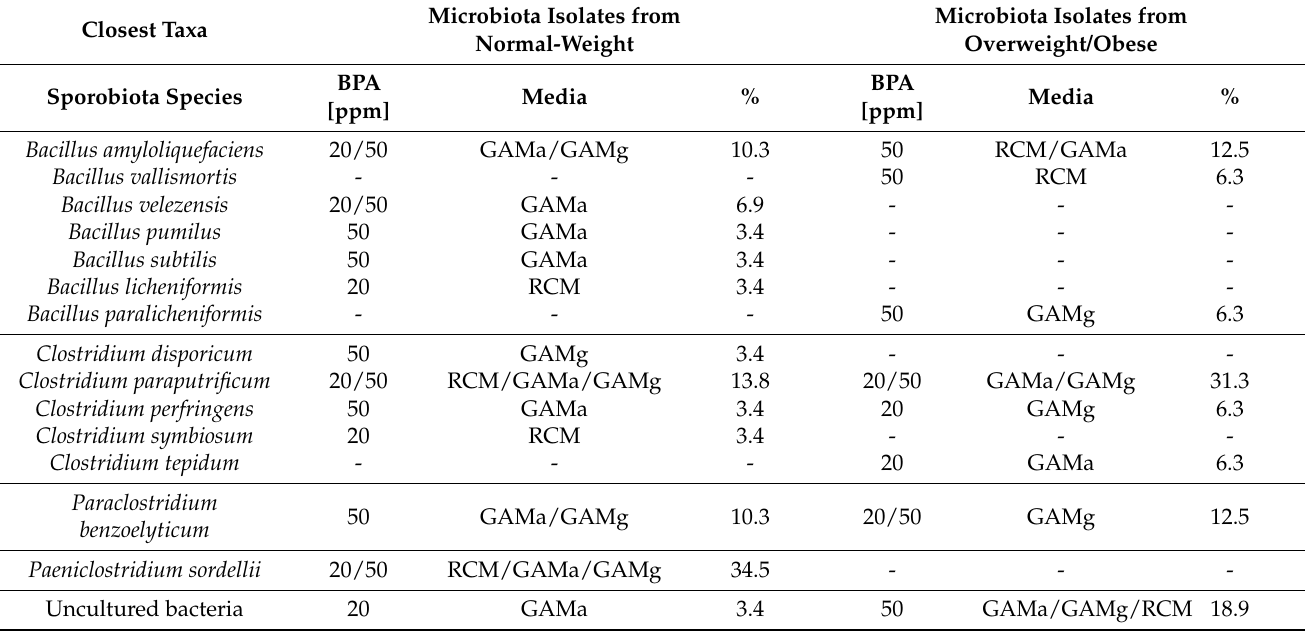
BPA tolerant spore-forming bacteria taxa cultured from normal-weight and over- weight/obese